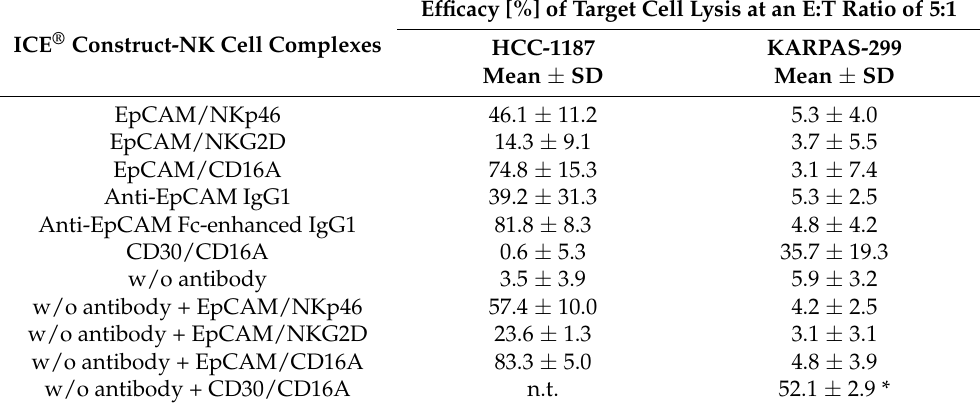
Table 8. Efficacy of cryopreserved and revived ICE ® constructs pre-complexed with NK cells.